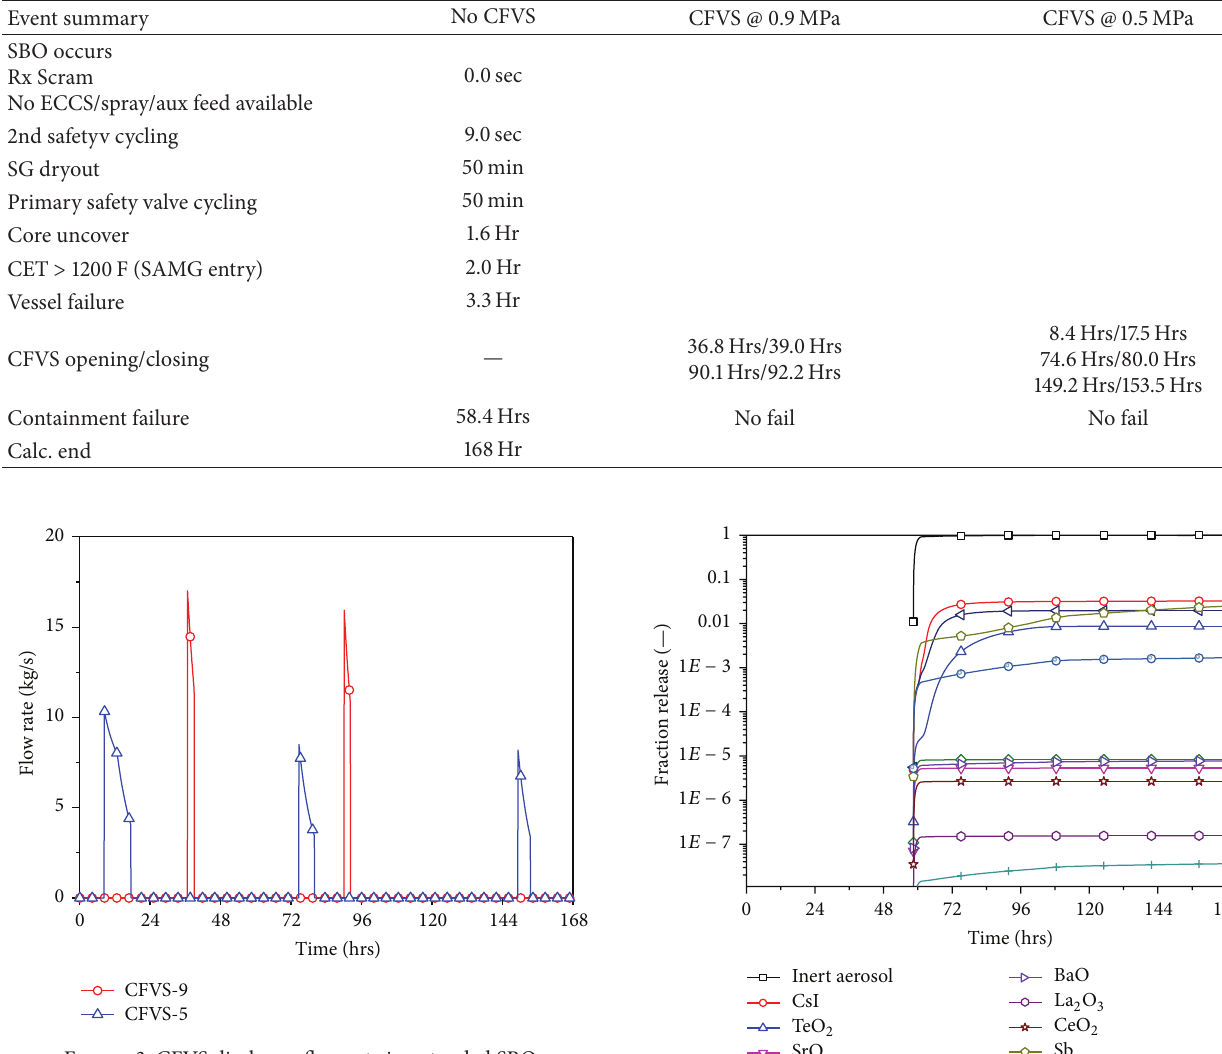
Figure 3: CFVS discharge flow rate in extended SBO.